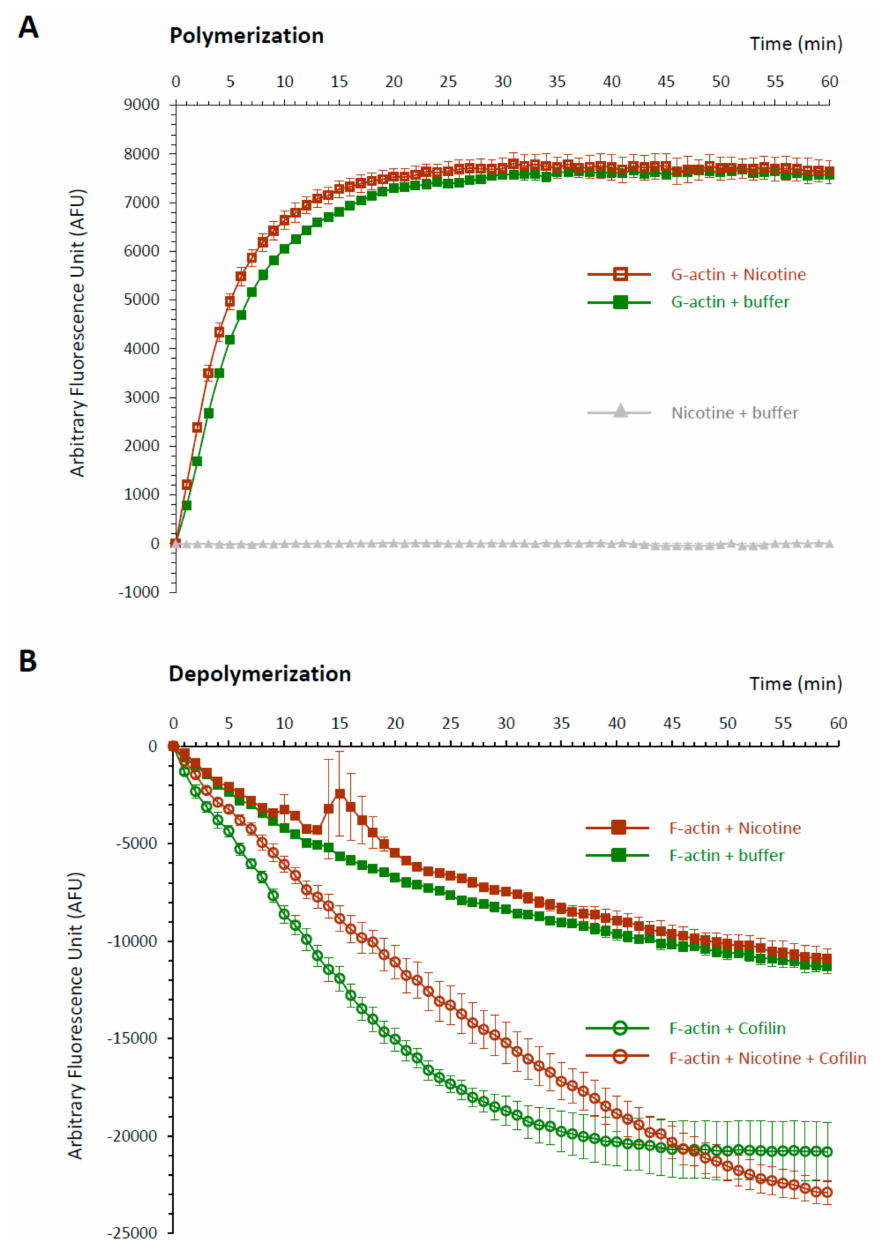
Figure 10. Direct impact of nicotine on the polymerization and depolymerization dynamics of actin. ( A ) Actin polymerization kinetics was assessed following the procedures described in Materials and Methods. The trajectories of the actin polymerization kinetics in the presence or absence of 24 µ M nicotine were marked by open brown squares and filled green squares, respectively. Each data point in every curve represents mean ± SD obtained from quadruple samples. Gray triangles represent the virtually unchanging background levels of fluorescence in the wells containing the bu ff er and nicotine (note that the error bars are small enough to be masked by the symbols). ( B ) The depolymerization kinetics of pre-polymerized F-actin in the presence (brown squares) or absence (green squares) of 24 µ M nicotine. Please note that addition of 1.2 µ M cofilin to the reaction mixture steeply accelerated the depolymerization kinetics (open green circles). When 24 µ M nicotine was introduced to the F-actin mixture 1 min prior to the cofilin addition, cofilin was appreciably less e ff ective in depolymerizing F-actin (brown open